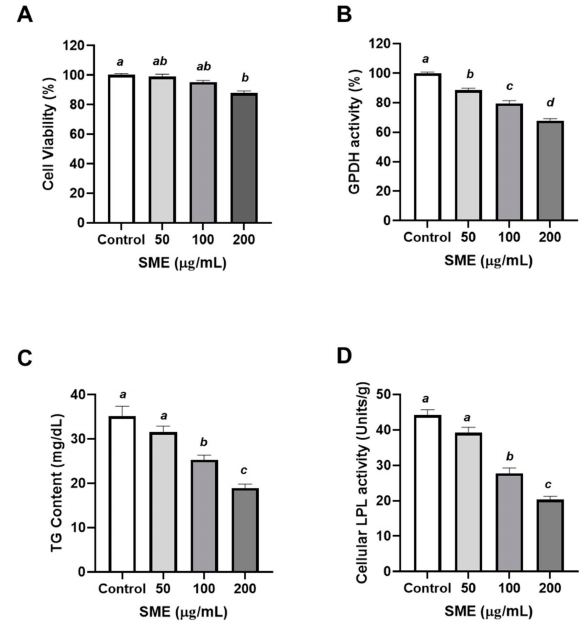
Figure 1. E ff ects of ethanol extract of Spergularia marina (SME) on proliferation and di ff erentiation of 3T3-L1 cells. The 3T3-L1 pre-adipocytes were treated with SME (50, 100, and 200 µ g / mL) for 48 h. Dimethyl sulfoxide (DMSO) was used as control. ( A ) Cell proliferation was determined by 3-(4,5-dimethylthiazol-2-yl)-2,5-diphenyltetrazolium bromide (MTT) assay. ( B ) Adipocyte di ff erentiation was accessed by glycerol-3-phosphate dehydrogenase (GPDH) measurement ( C